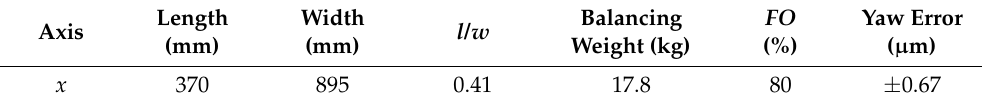
Table 11. Platform dimensions and predicted yaw error for the improved x-axis stage.